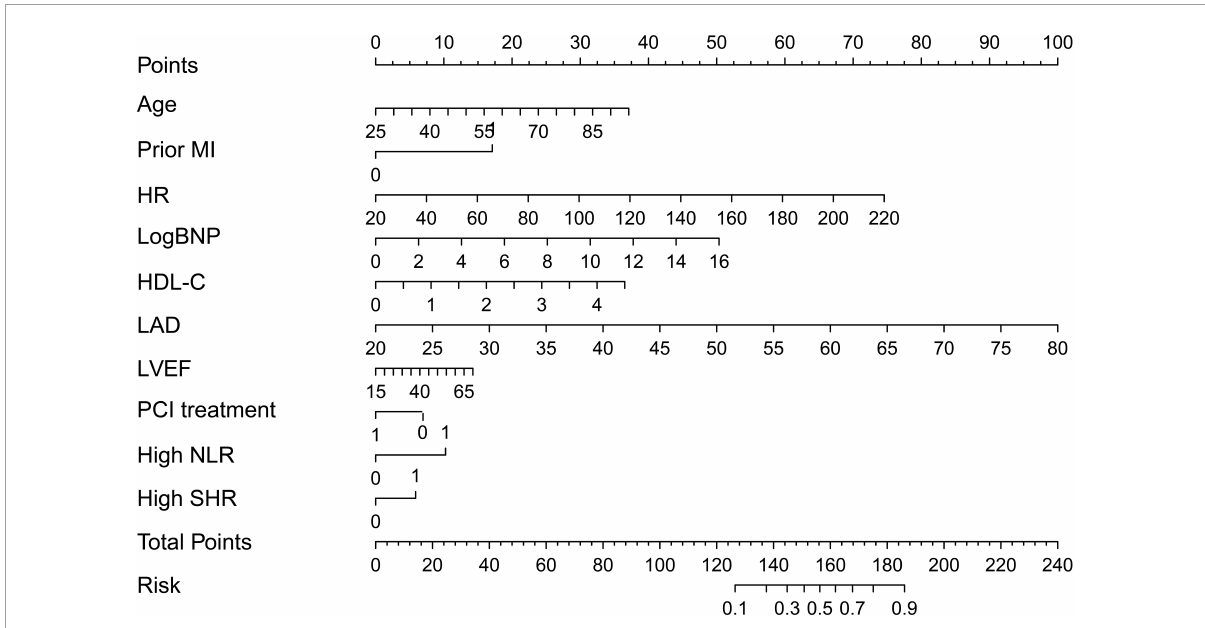
FIGURE4 Nomogram to calculate risk score and predict the incidence of new-onset atrial fibrillation (NOAF) in patients with acute myocardial infarction (AMI). MI, myocardial infarction; HR, heart rate; LogBNP, log-transformed B-type natriuretic peptide; HDL, high-density lipoprotein; LAD, left atrium diameter; LVEF, left ventricular ejection fraction; PCI, percutaneous coronary intervention; NLR, neutrophil to lymphocyte ratio; SHR, stress hyperglycemia ratio.